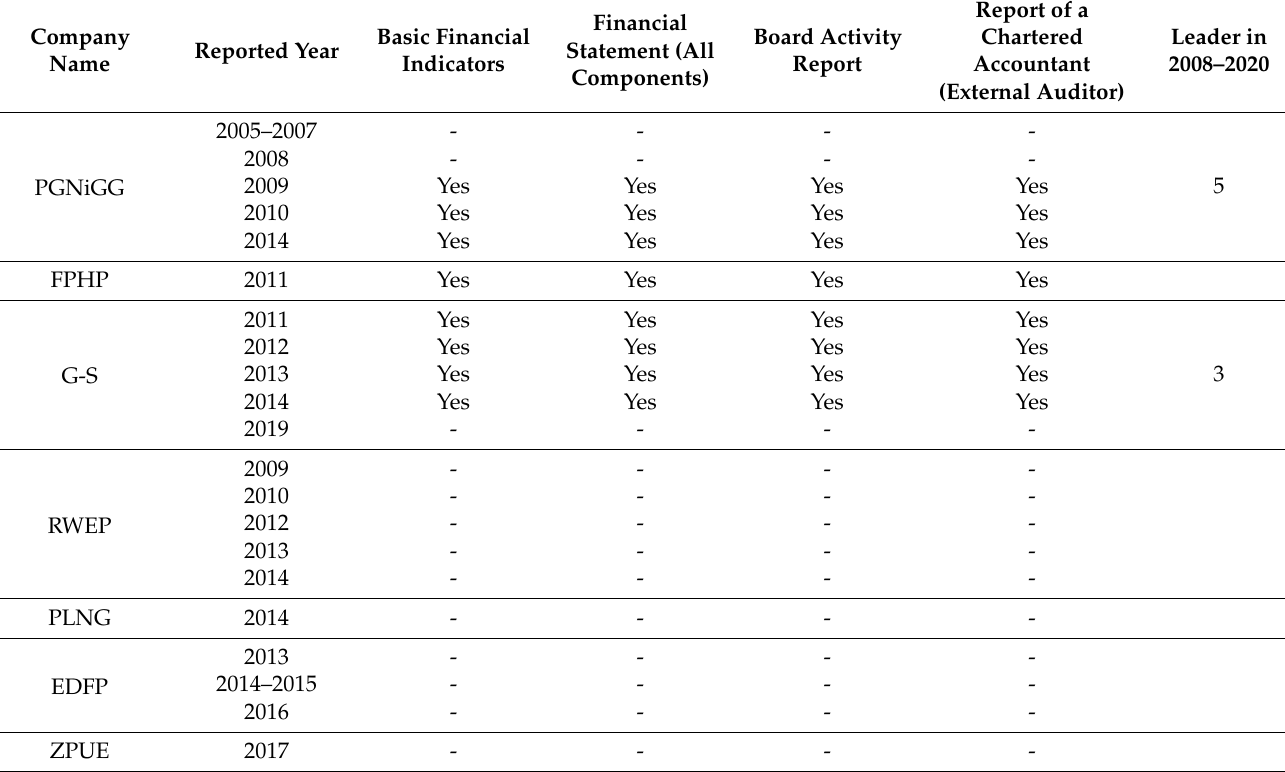
Table A1. Financial data published on energy companies on corporate